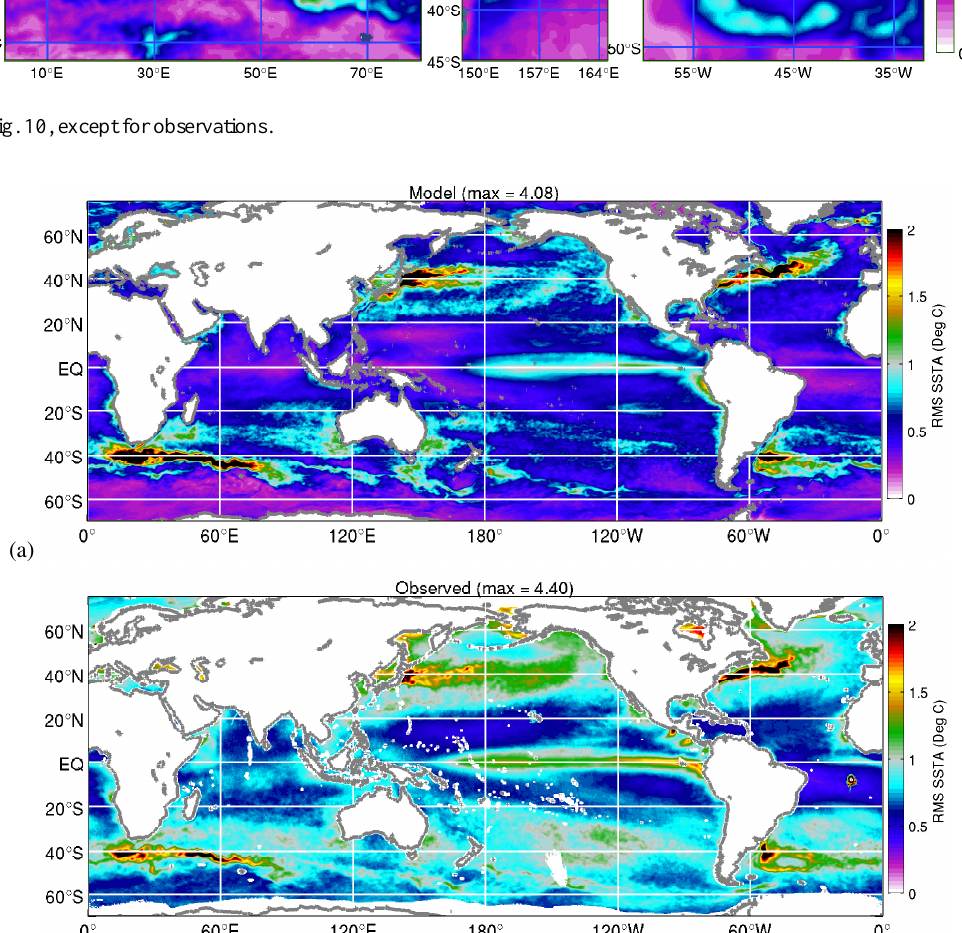
Fig. 12. Comparison of the RMS SSTA from the (a) model and (b) observations.